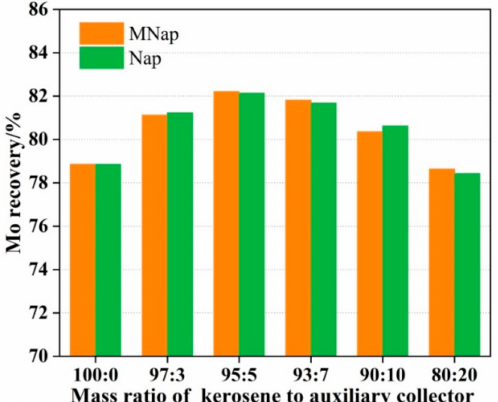
Figure 6. The effect of mass ratio of kerosene to MNap on molybdenite flotation (collector 170 g/t, frother 90 g/t).